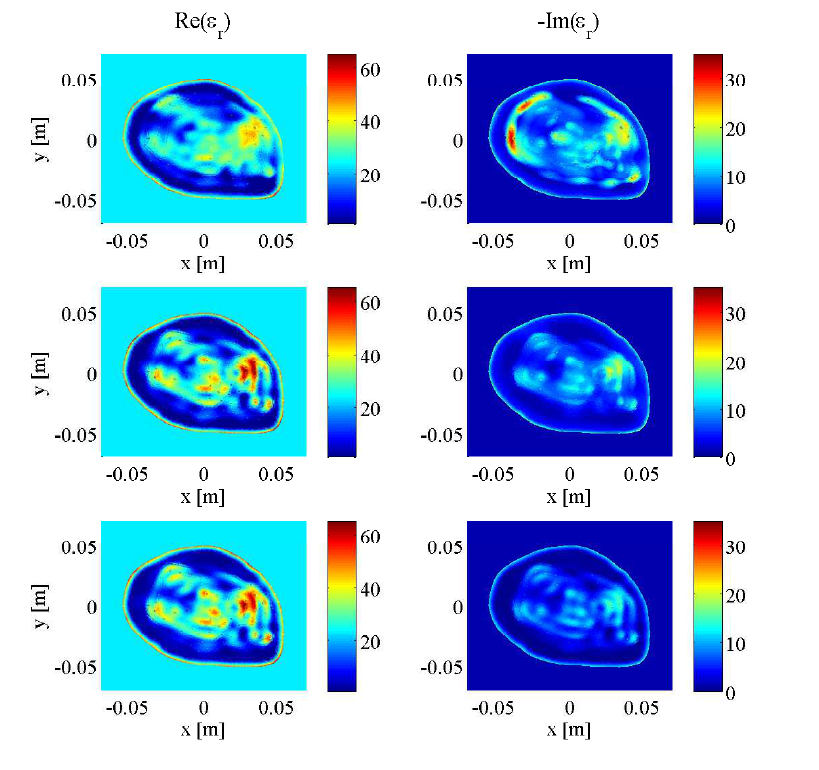
Figure 8. Final results of DGM-CSI frequency-hopping and frequency-cycled complex dielectric property reconstruction of synthetic breast model using 1.0–3.0 GHz data, without modification of intermediate initial guesses (Scenario A— top ), using tissue-dependent mapping at fixed 200 iterations per frequency (Scenario B— middle ), and employing stopping criteria and tissue-dependent mapping (Scenario C— bottom